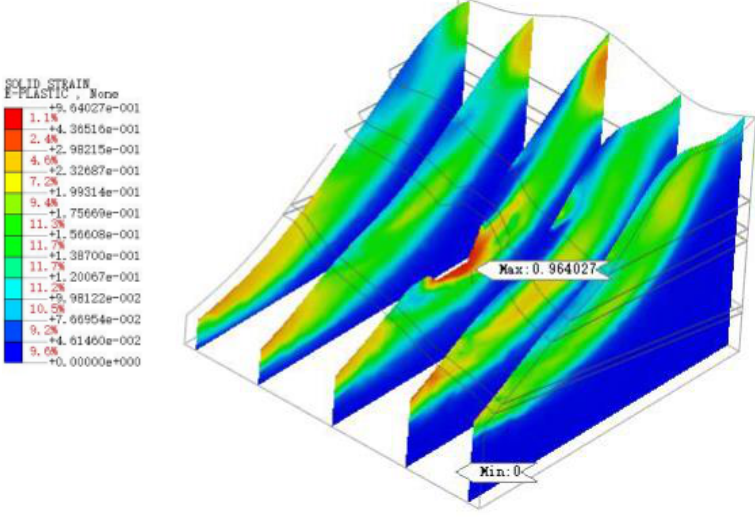
Figure 26. Equivalent strain of slope.